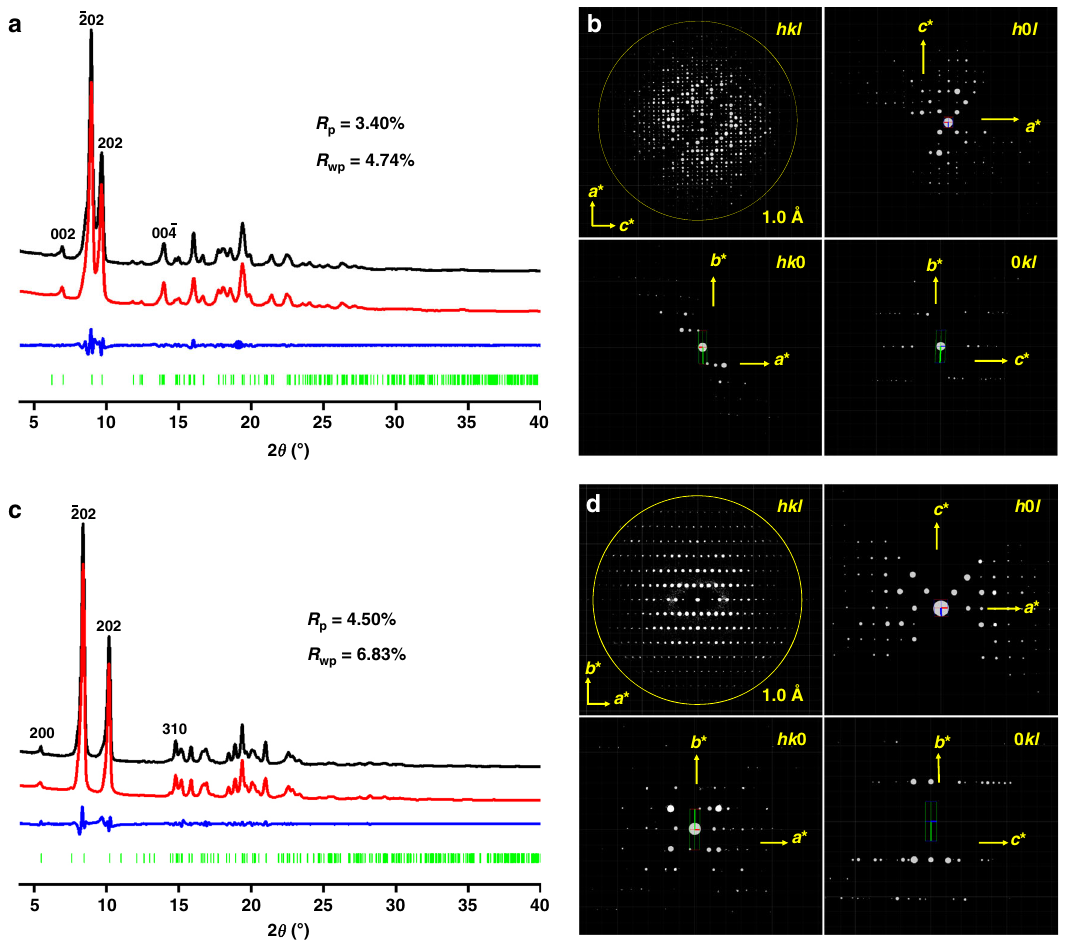
Fig. 2 The Rietveld re fi nement and 3D reciprocal lattice. The Rietveld re fi nement of 3D-TPB-COF-HQ ( a ) and 3D-TPB-COF-Q ( c ): the experimental XRD patterns are shown in black, the Rietveld re fi nement patterns in red, and their difference in blue, Bragg position from the fi ve-fold interpenetrated pts net in green. 3D reciprocal lattice of 3D-TPB-COF-HQ ( b ) and 3D-TPB-COF-Q ( d ). The same re fl ection conditions ( hk 0: h + k = 2n; h 0 l : h = 2n, l = 2n) of 3D- TPB-COF-HQ and 3D-TPB-COF-Q was obtained by h 0 l , 0 kl , and hk 0 slices cut from the 3D reciprocal